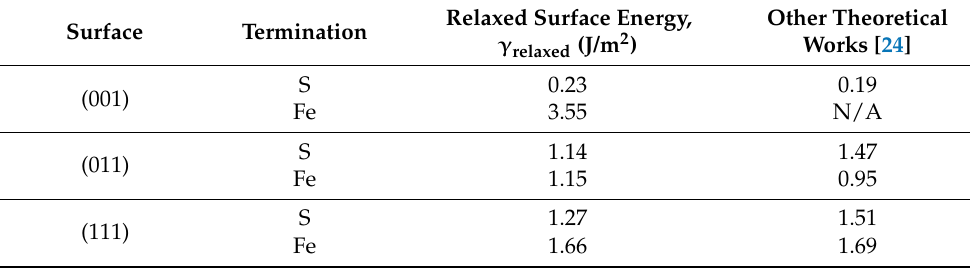
Table 1. Calculated relaxed surface energies of three low Miller index surfaces of FeS.